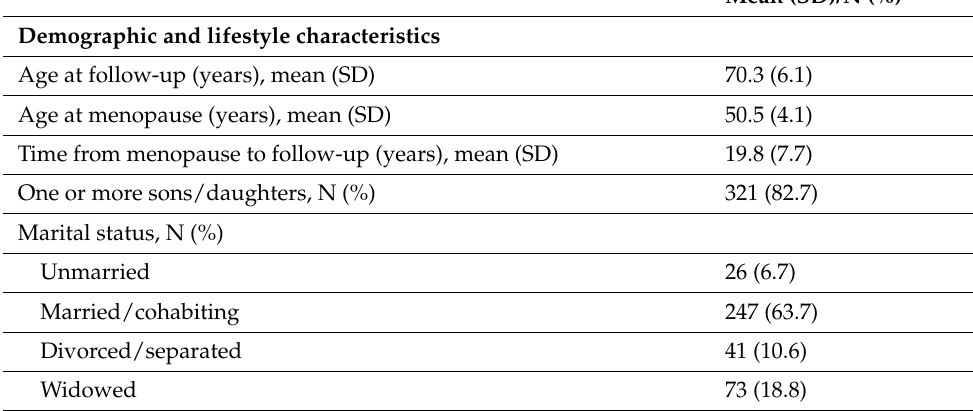
Table 1. Means (SD) and distribution (N, %) at follow-up of the main characteristics of the 388 EPIC-Florence participants with follow-up